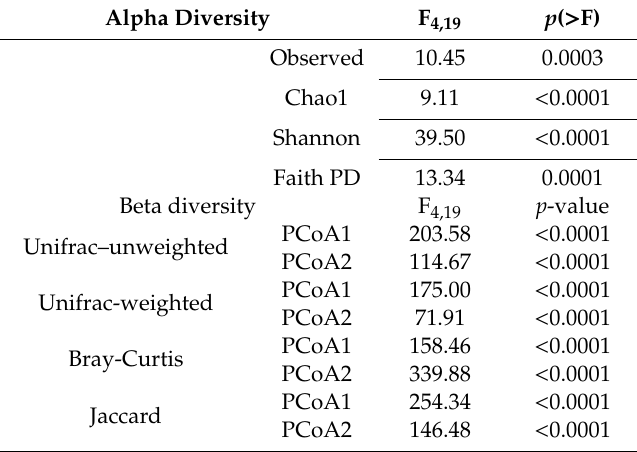
Table 1. Results from mixed-e ff ects models are shown for α - and β -diversity indices. Significance was determined using ANOVA. For each test, we report the relevant F statistic ( F 4,19 ) and significance ( p ( > F )). Degrees of freedom were constant across all tests (numerator degrees of freedom: 4, denominator degrees of freedom: 19). Alpha Diversity F 4,19 p ( > F)